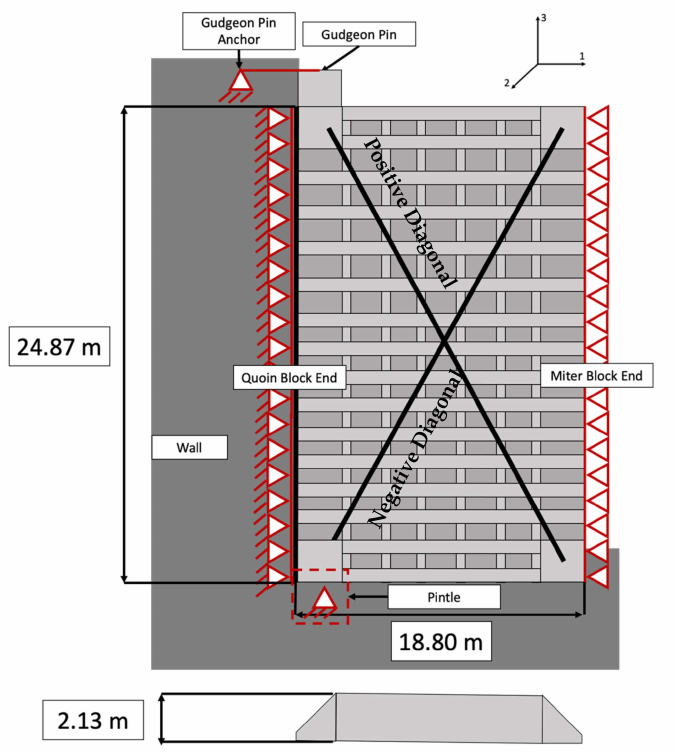
Figure 9. Graphic illustration showing geometry and displacement boundary conditions for the method validation